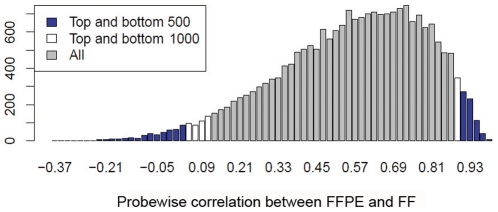
Distribution of the probewise correlation between FFPE and FF matching pairs.The x-axis reports the probewise correlation between FFPE and FF matching pairs, the y-axis the corresponding number of probes. The 1000 and 500 most and least correlating probes are highlighted in white and blue respectively.